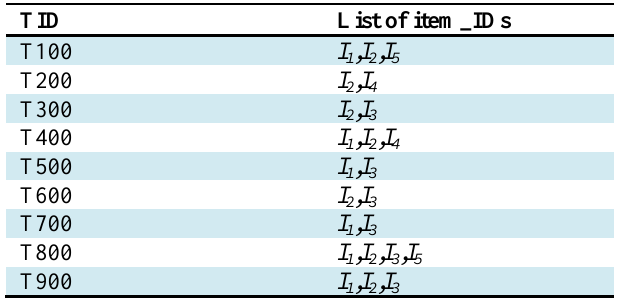
Table1. Transactional data for an AllElectronics branch TID